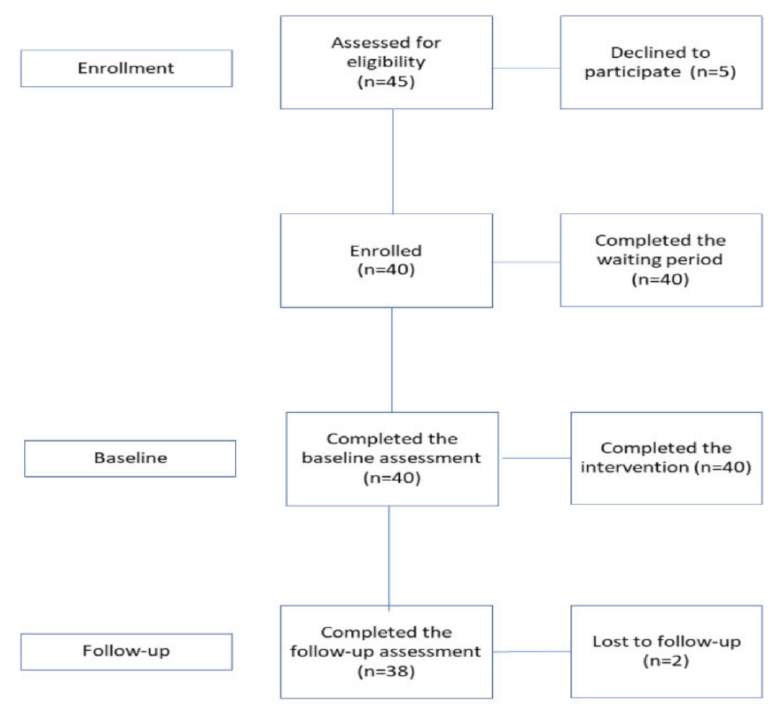
Figure 1. Participant